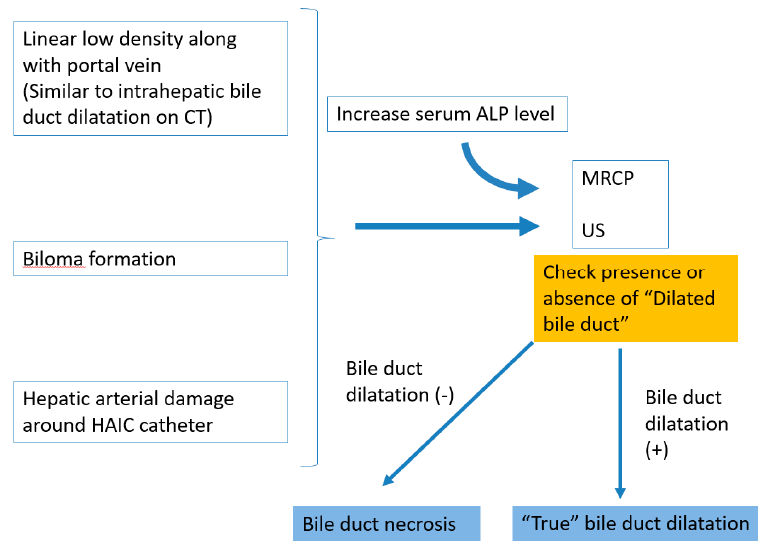
Figure 16. Diagnostic algorithm of BDN during the course of repeated transcatheter chemoembolization therapy (TACE) or hepatic arterial infusion chemotherapy (HAIC) for treatment of a liver